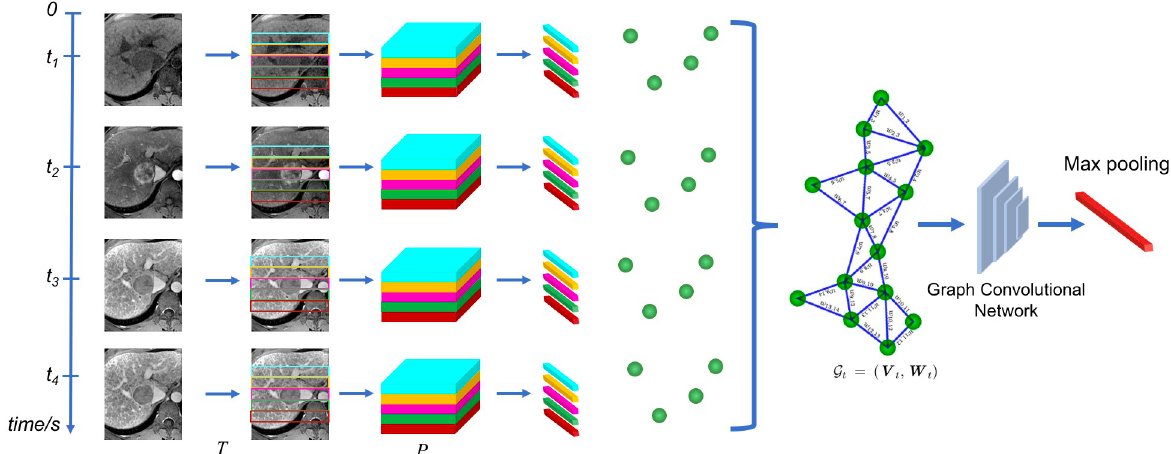
Fig 3. Schematic representation of the the temporal branch, where a series of patches are extracted from the input volumes and features partitioned to generate a total of T × P patches for a particular input sequence. Graph nodes are constructed from temporal feature patches, providing a representation of the entire sequence such as G max pool operation to obtain the feature vector.